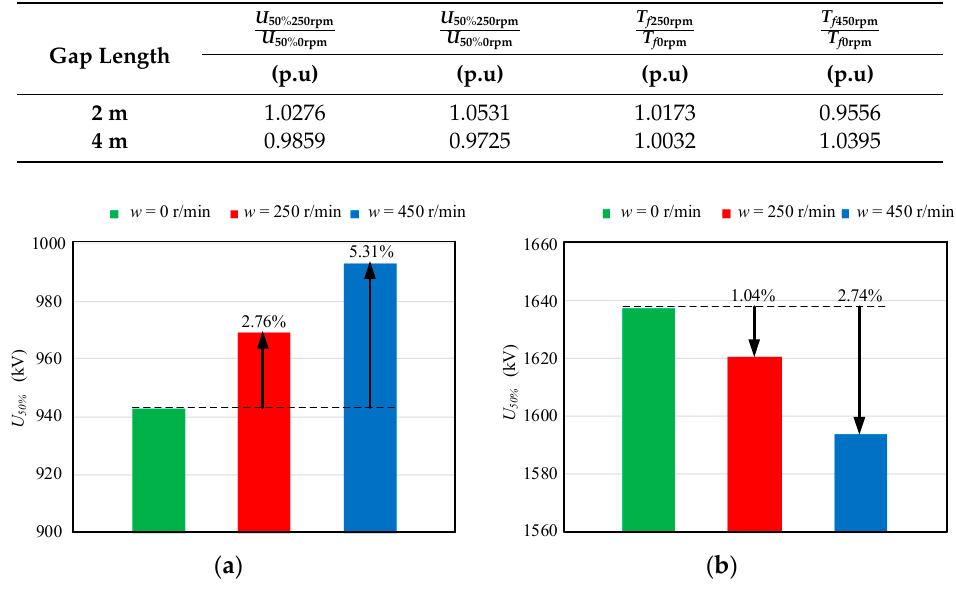
Figure 5. Relationship between U 50% and w in different air gaps. ( a ) 2 m air gap; ( b ) 4 m air gap.